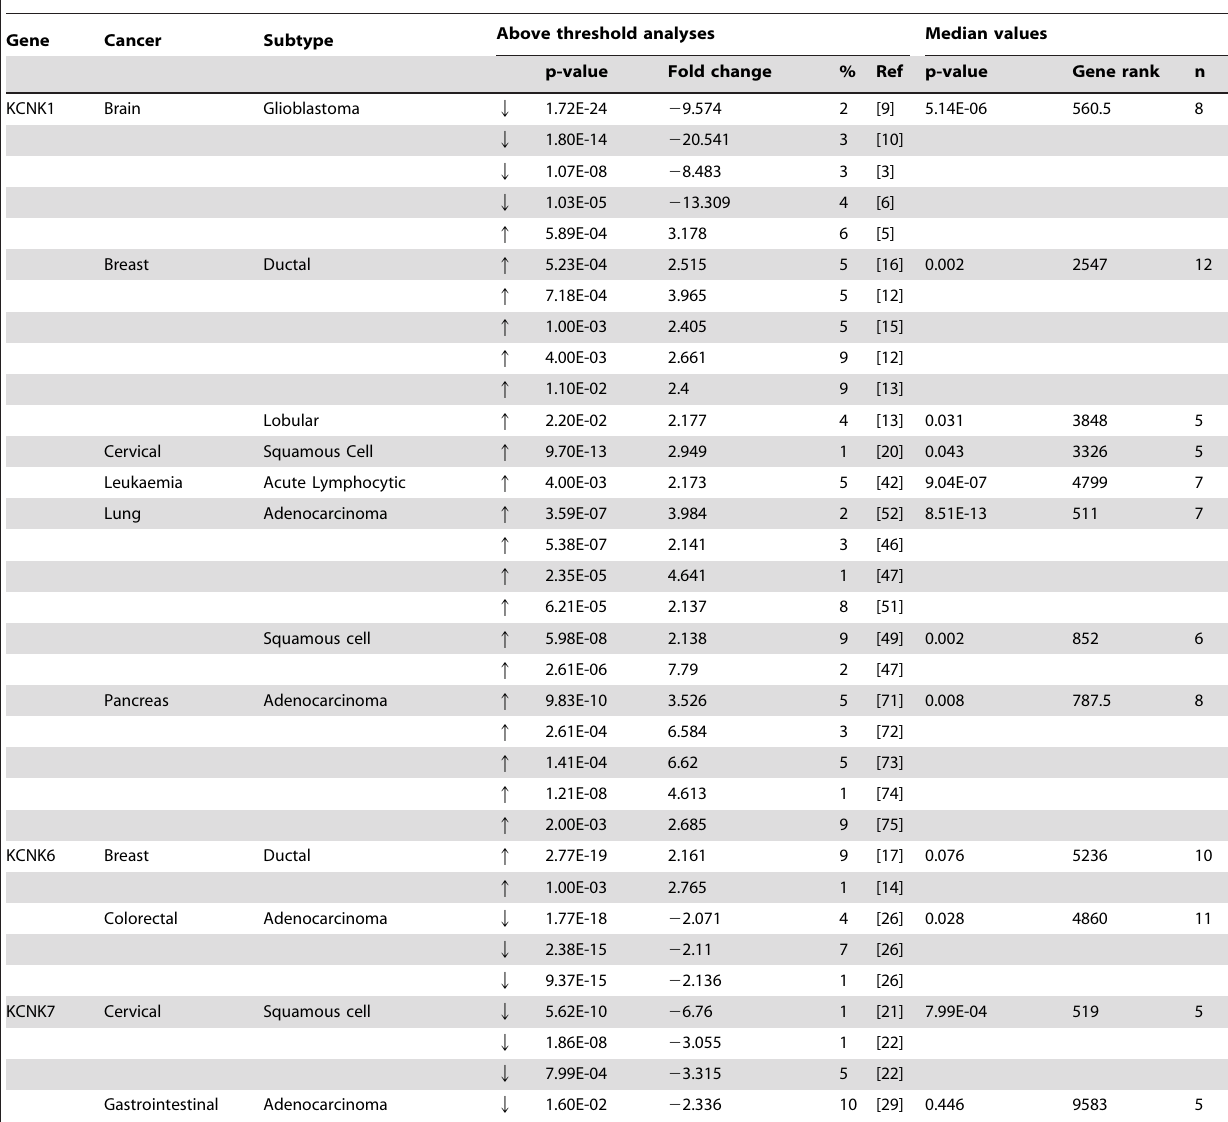
Table 2. TWIK family members expression in cancer.